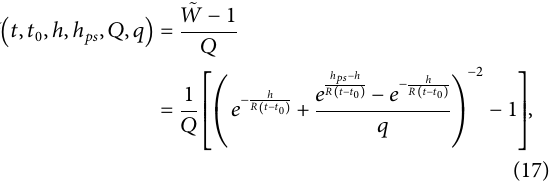
TABLE 1 Results obtained from fi tting for experimental data taken from Scholtz et al. (1991). The fi rst column shows chain length (in repeated units), and the next four columns show fi tting parameters, describedinthetext;numbersinbracketsshowerrorsinpercentages. Nucleation parameter σ is recalculated as 1/ Q . For all fi ts, the coef fi cient of determination is R 2 = 0.999. Energies are measured in Joules per mole and temperature in